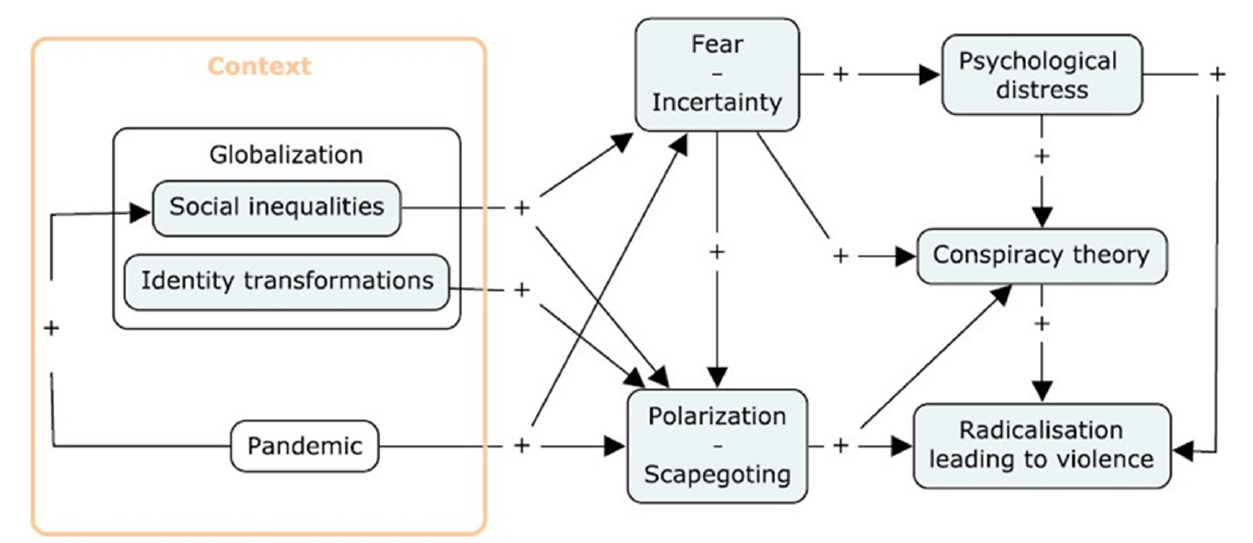
Figure 1. Radicalization leading to violence, endorsement of COVID ‐ 19 conspiracy theories and psychological distress in relational context.